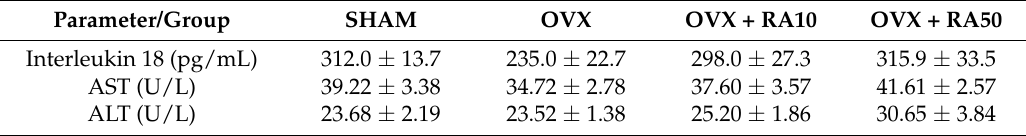
Table 2. Effect of rosmarinic acid on the serum concentration of interleukin 18, and activity of aspartate aminotransferase (AST) and alanine aminotransferase (ALT) in ovariectomized rats. Parameter/Group SHAM OVX OVX + RA10 OVX + RA50 Interleukin 18 (pg/mL) 312.0 ± 13.7 235.0 ± 22.7 298.0 ± 27.3 315.9 ± 33.5 AST (U/L) 39.22 ± 3.38 34.72 ± 2.78 ALT